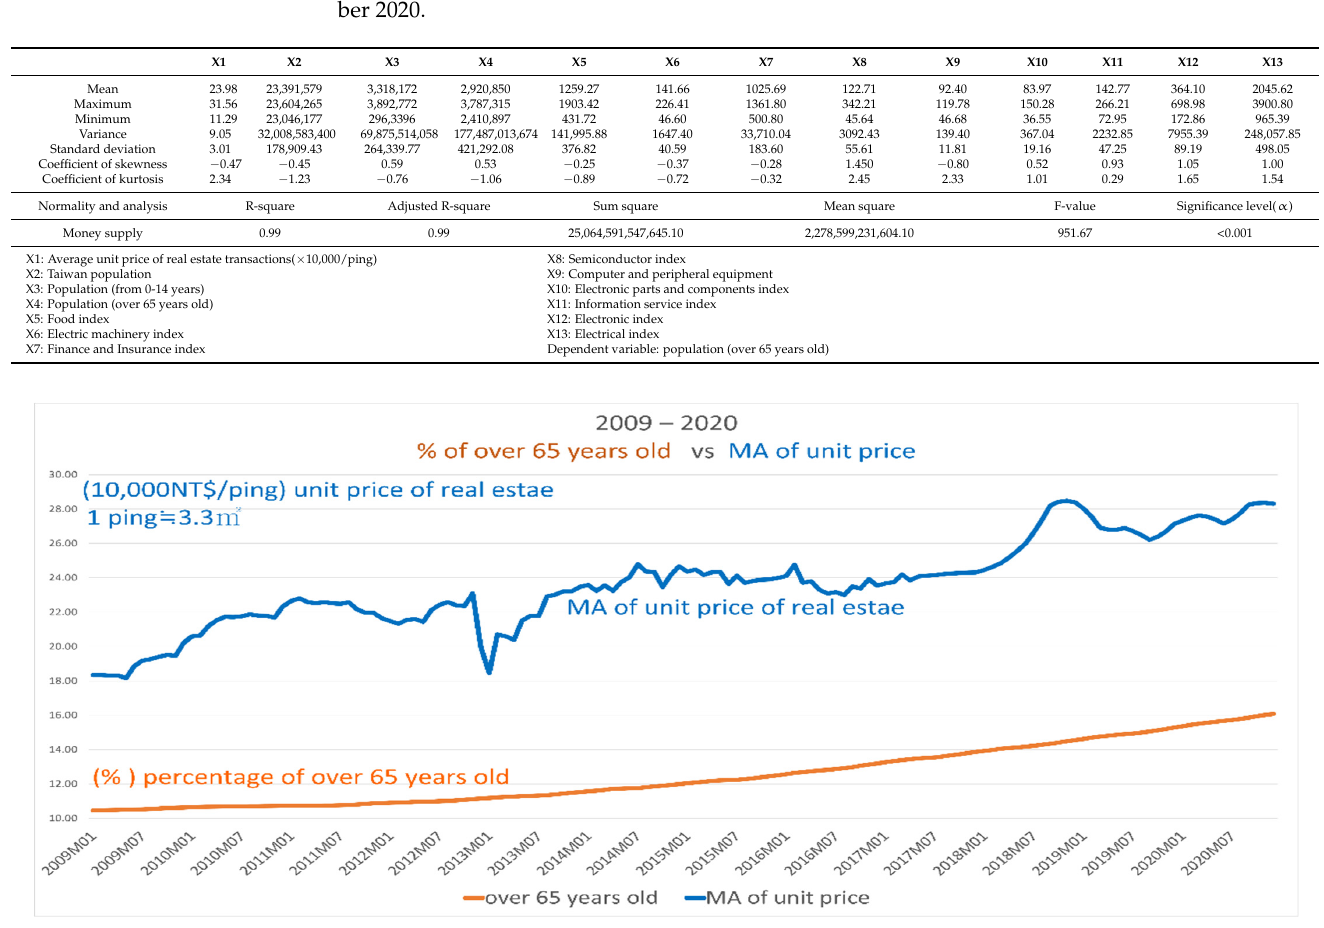
Table 2. Descriptive statistics of indexes related to population group from January 2009 to Decem-